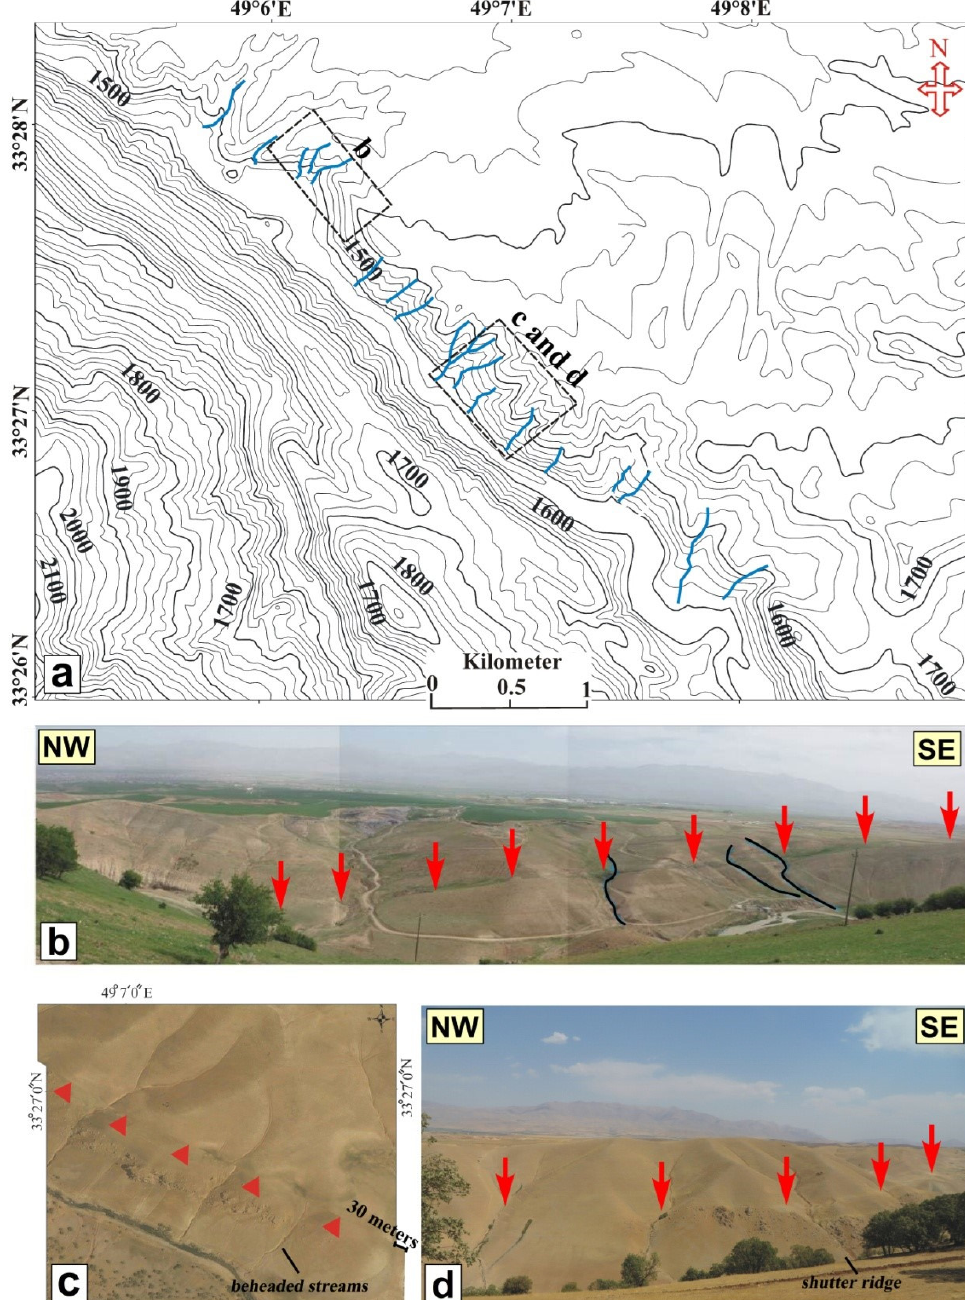
Figure 6. The Doroud Fault trace with offset reconstruction for drainage s in the Quaternary sediments. The blue line and red arrows show rivers and fault traces, respectively. The red and blue arrows indicate fault trace and rivers, respectively. The dark box indicate the location of the ( b – d ). ( a ) The topographic map of the central part of the area. Black lines delineate a topographic crest for calcu- lating the ratio of vertical and horizontal displacement across the fault. ( b ) Field photograph of three offset rivers with fault trace within young alluvial. Offsets from left to right are 13 ± 2 m, 20 ± 3 m, and 23 ± 2 m, respectively. ( c ) SASPlanet image view of the reconstruction of the drainage to its initial position after back-slip (30 ± 2 m) along the fault trace. ( d ) Another field photograph of sev- eral offset drainage with fault traces.